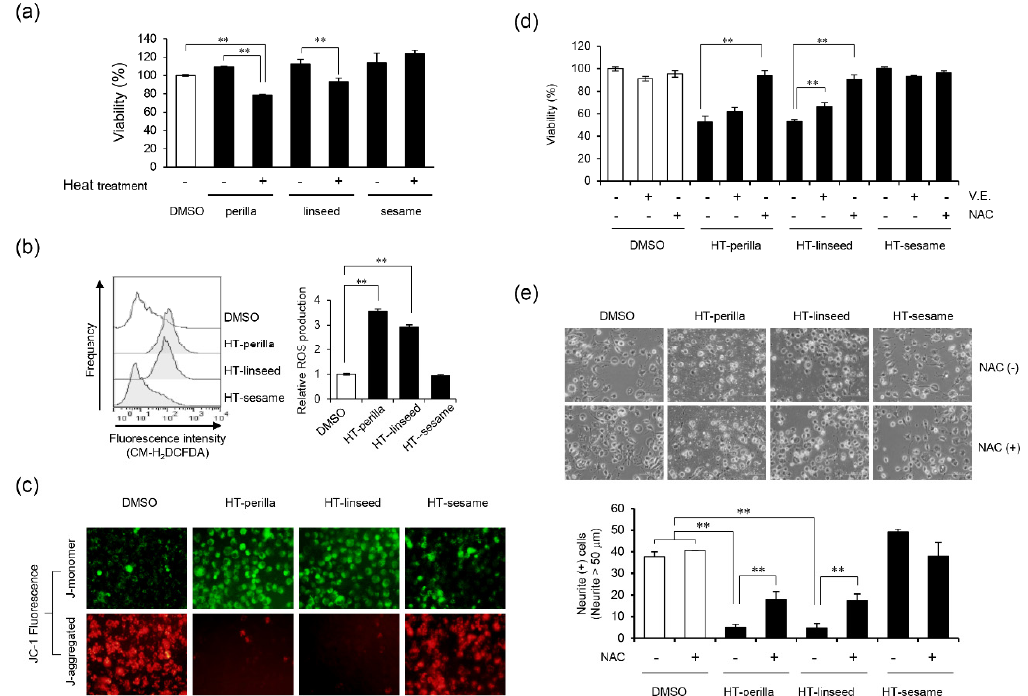
Figure 2. Injury of SH-SY5Y cells by heat-treated oil and the preventive e ff ect of antioxidants. ( a ) Analysis of cell viability after exposure to heat-treated or unheated oils. After incubation with unheated (0 d) or heat-treated oil (3 d, 1 mg / mL) for 24 h, cell viability was measured using a Cell Counting Kit-8. One-way ANOVA with Tukey–Kramer’s test was used. ** p < 0.01 compared with DMSO treatment. ( b ) Intracellular ROS production induced by oxidized oils. SH-SY5Y cells were exposed to 1 mg / mL oxidized perilla, linseed, or sesame oil for 3 h in DMEM media containing 1% fatty acid-free BSA. Cells were stained with CM-H 2 DCFDA, and then subjected to flow cytometry analysis. The left panel shows a histogram, while the right panel shows relative ROS production levels calculated by the mean value of the fluorescence level. One-way ANOVA with Dunnett’s test was used. ** p < 0.01 compared with control (DMSO). ( c ) Fluorescence imaging of ∆Ψ m in SH-SY5Y cells by fluorescence microscopy. Cells were exposed to heat-treated oils as indicated for 24 h, and then stained with JC-1. The J-aggregated form (red, healthy) and J-monomer form (green, apoptotic) were measured at 570 and 535 nm, respectively. Representative data of at least three experiments are shown. ( d ) Cells were pretreated with NAC (10 mM, 12 h) or vitamin E (10 µ M, 2 h), and then exposed to heat-treated oil (3 d, 1 mg / mL) for 24 h. Cell viability was measured using a Cell Counting Kit-8. One-way ANOVA with Dunnett’s test was used. ** p < 0.01 compared with control (HT-perilla